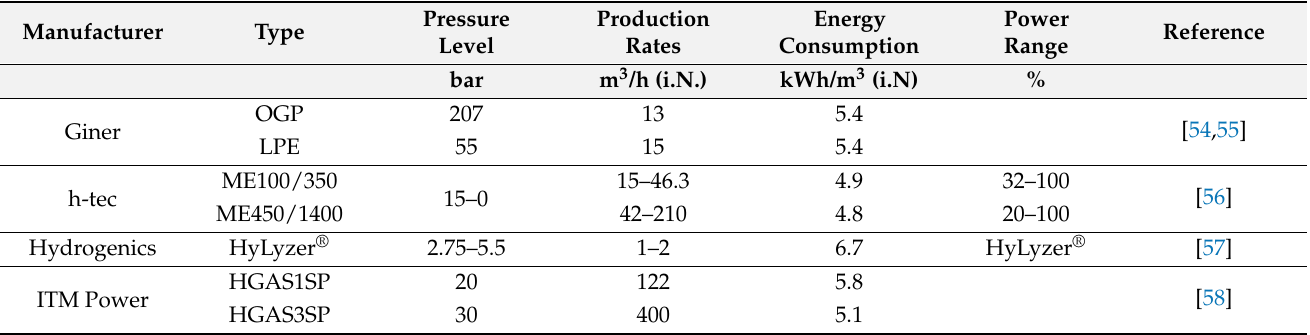
Table 1. Commercially-available electrolysis